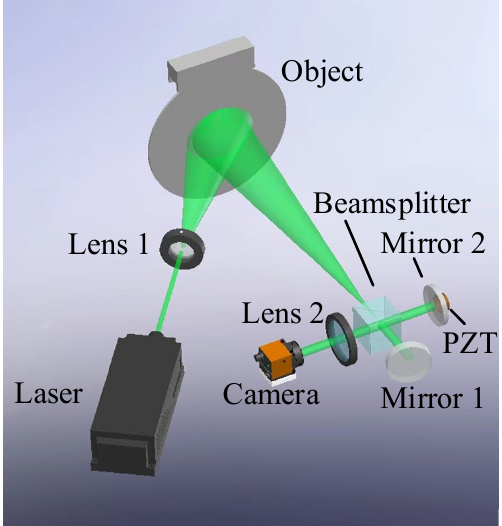
Figure 2. Michelson-type digital shearography system.